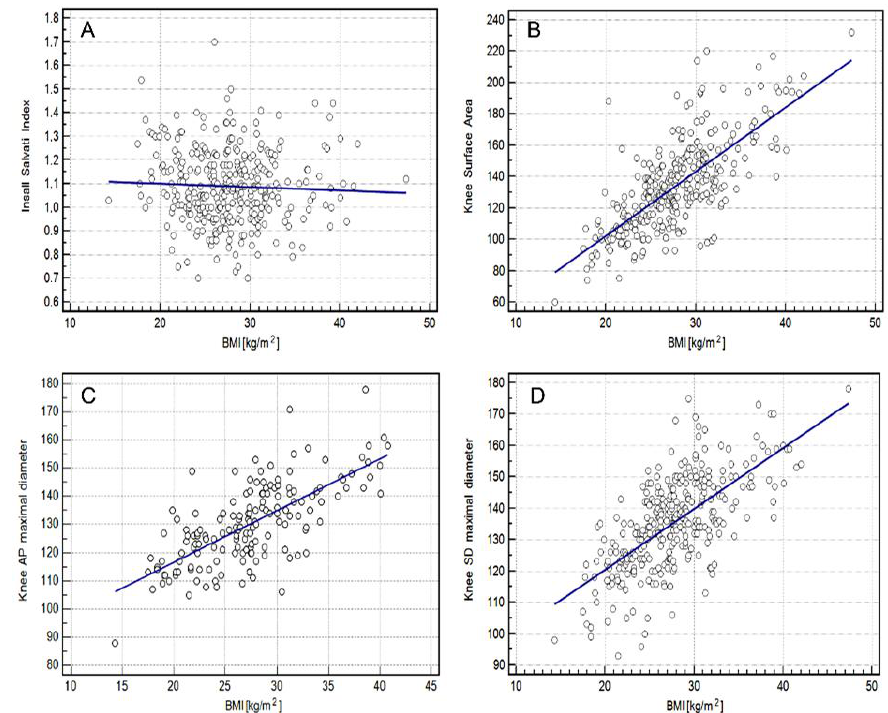
Figure 4. Relationship between BMI (Body Mass Index) and knee measurement using both scanners (1.5 T and 3.0 T) in the study group. ( A )—Insall Salvati index; ( B )—Knee Surface Area; ( C )—Knee AP (anterior-posterior) Maximal Diameter, ( D )—Knee SD (sinistro-dexter) Maximal Diameter.